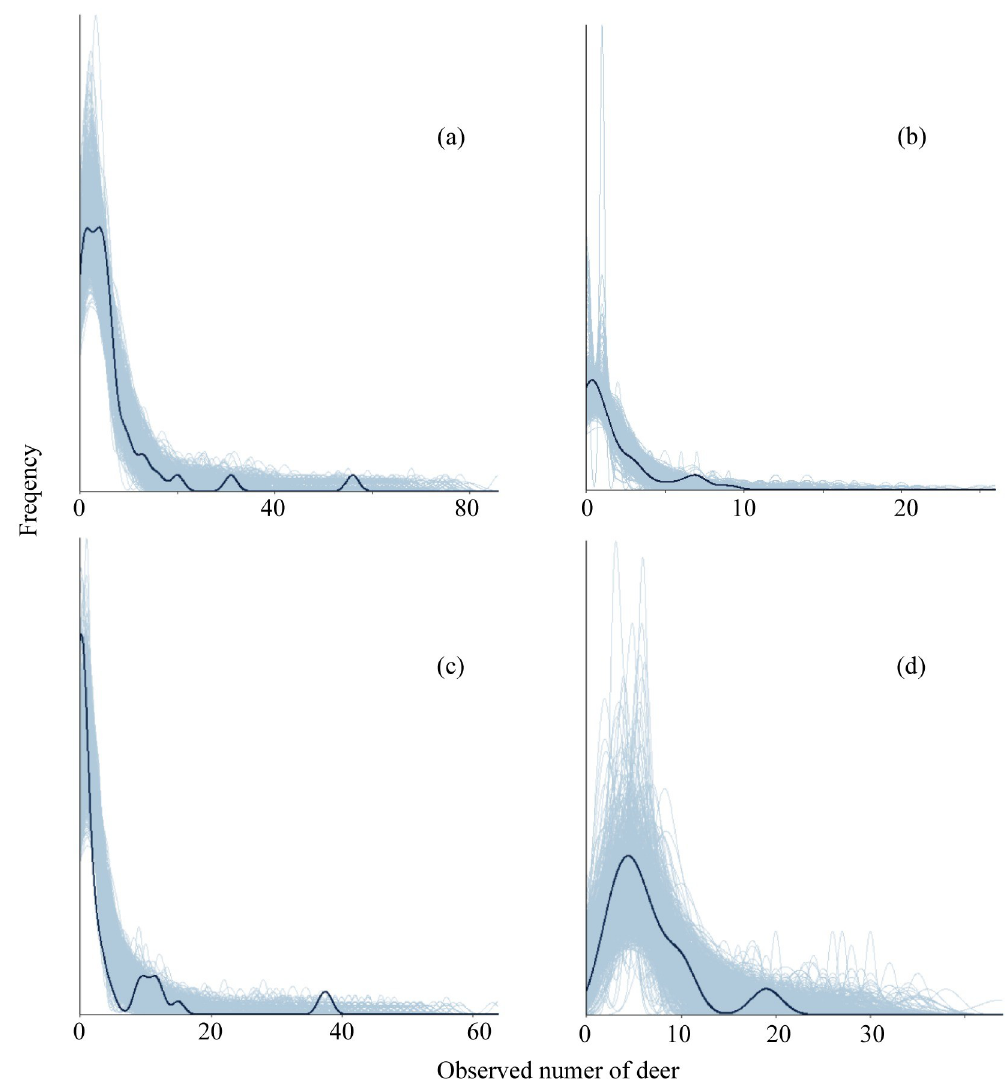
Fig 3. Kernel density estimate of the observed data set (dark blue lines) with density estimates for 1000 simulated data sets drawn from the posterior predictive distribution (light blue lines). (a) C a , (b) C b , (c) C e , (d) B.